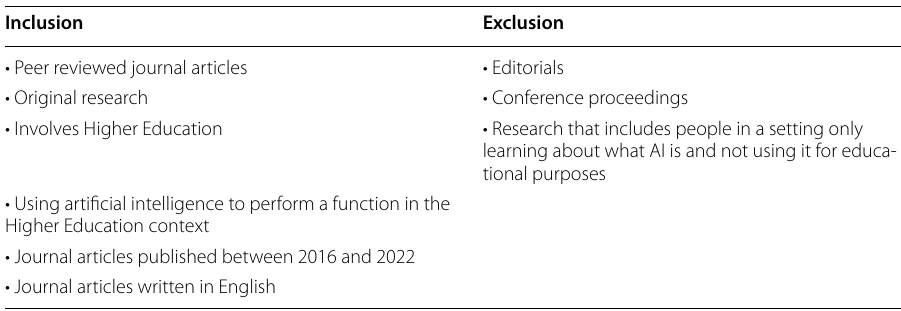
Table 2 Inclusion/exclusion criteria